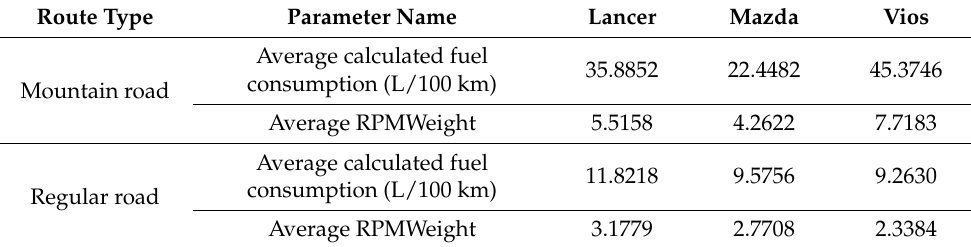
Table 5. Comparison of average fuel consumption between mountain and regular